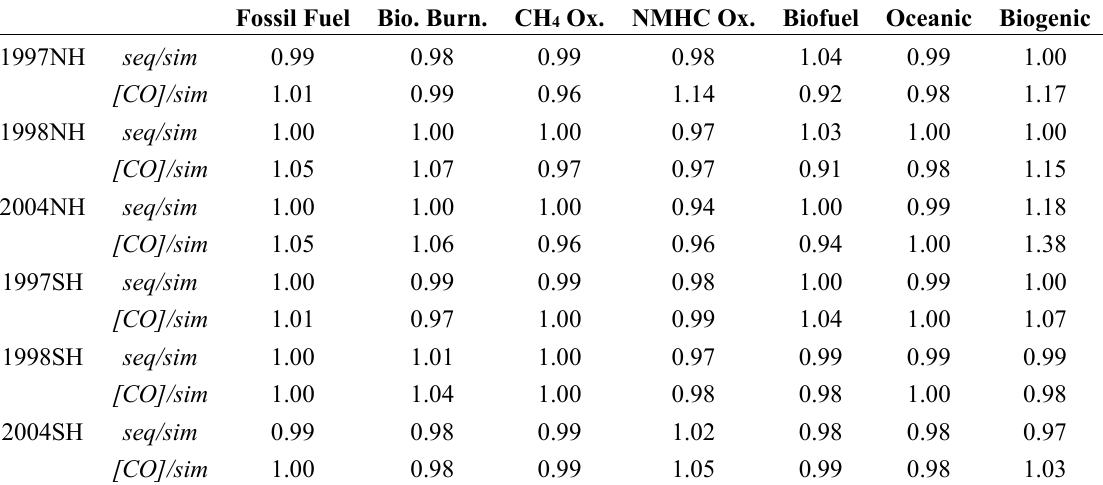
Table 5. The ratios of optimization factors. seq/sim is ratio of optimization factor of sequential inversion to that of simultaneous inversion and CO/sim is ratio of optimization factor of CO-only inversion to that of simultaneous inversion. Mean deviation from the unity (identical result) is ±1.7% for seq/sim and ±4.6% for CO/sim . Fossil Fuel Bio. Burn. CH 4 Ox. NMHC Ox. Biofuel Oceanic Biogenic